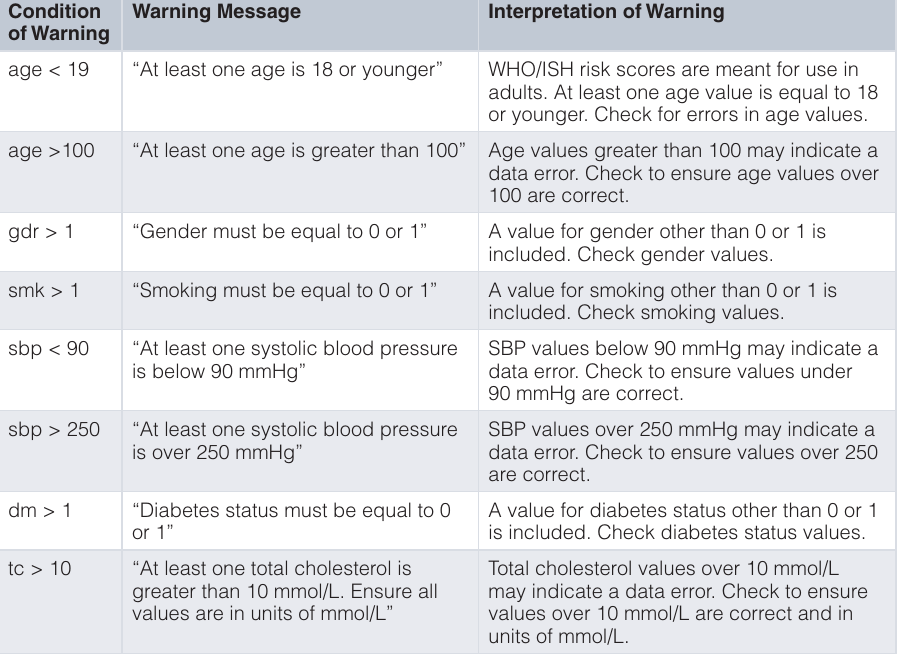
Table 2. WHO_ISH_Risk() warning messages, their conditions, and intended